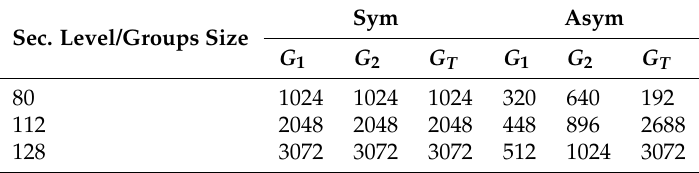
Table 7. Fields elements size (in bits) in different configurations for the ACSS scheme.